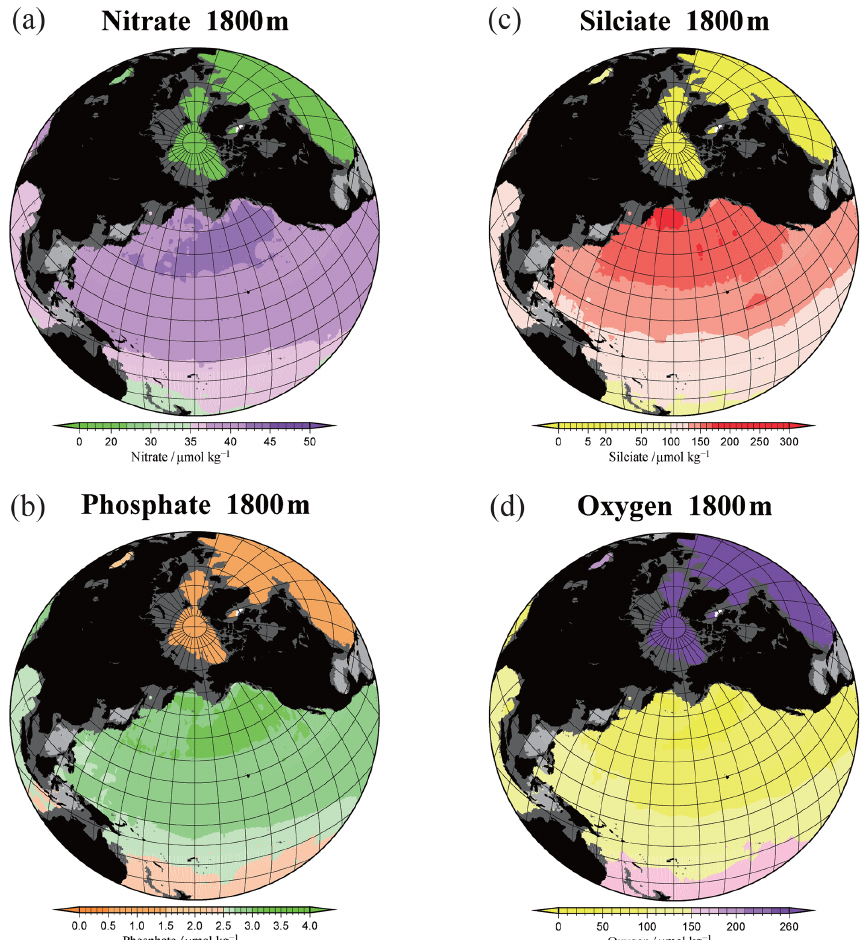
Figure 12. (a) Obtained nitrate concentration field at a depth of 1800m; (b) same as (a) but for phosphate; (c) same as (a) but for silicate; (d) same as (a) but for dissolved